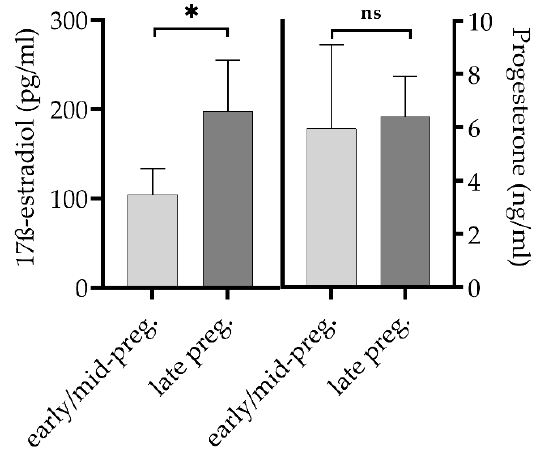
Figure 4. 17ß-estradiol (mean, 95% confidence interval) and progesterone (median, 95% confidence interval) levels of goats in early/mid-pregnancy ( n = 16) and in late pregnancy ( n = 23). Difference of 17ß-estradiol levels between both groups is significant ( * p = 0.01). ns = not significant